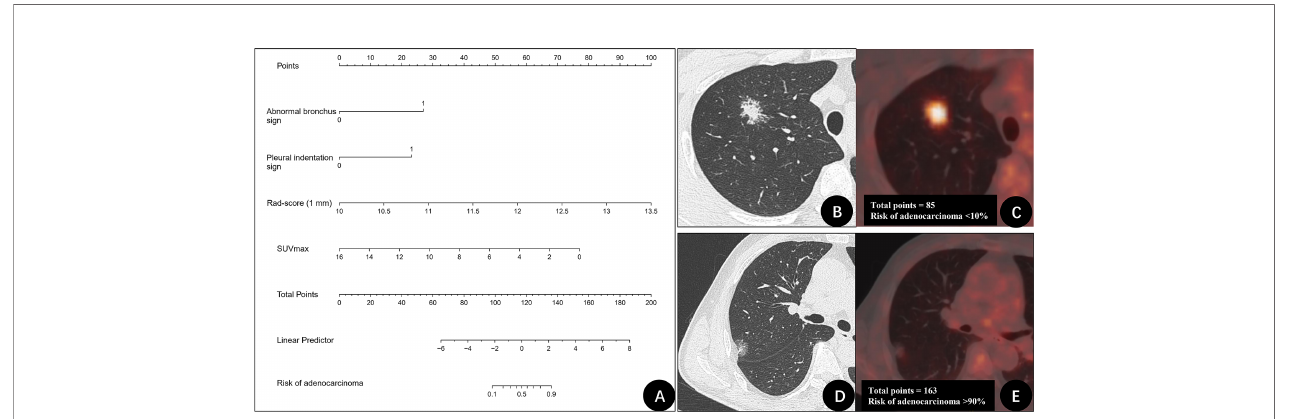
FIGURE 3 | The nomogram of PET + CT radiomics model for differentiating benign and malignant GGNs and two examples. (A) Nomogram of PET + CT radiomics model. (B, C) A 31-year-old man with a ground-glass nodule (GGN) on the right upper lung lobe. CT image (B) and PET/CT fusion image (C) show that nodule with abnormal bronchus sign (27 points), and no pleural indentation was identi fi ed (0 points). Rad-score (1 mm) was 10.7 (20 points), maximum standardized uptake value (SUVmax) was 8.1 (38 points). The total points were 85 points. The risk of adenocarcinoma for this nodule was < 10%. Postoperative pathologic fi ndings indicated granuloma. (D, E) A 61-year-old man with GGN on the right upper lung lobe. CT image (D) and PET/CT fusion image (E) show that nodule with abnormal bronchus sign (27 points) and pleural indentation sign (23 points). Rad-score (1 mm) was 11.3 (38 points), SUVmax was 1.1 (71 points). The total points were 163 points. The risk of adenocarcinoma for this nodule was > 90%. Postoperative pathologic fi ndings indicated invasive adenocarcinoma.